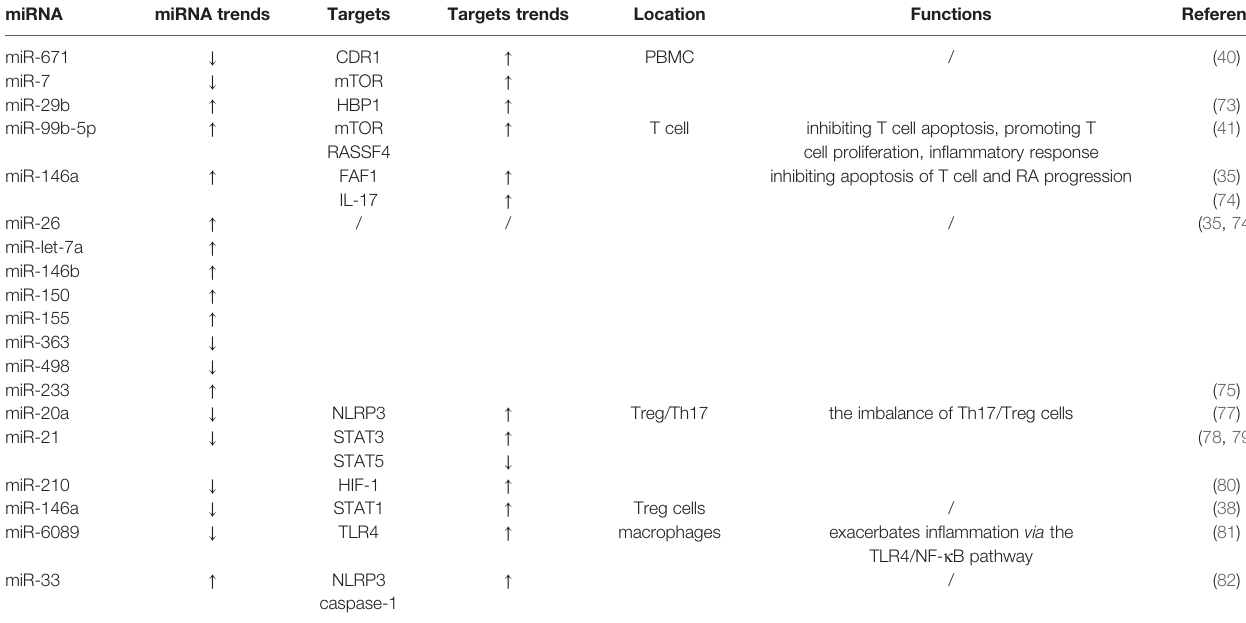
TABLE 1 | Effects of microRNAs on immune cells in rheumatoid arthritis. miRNA miRNA trends